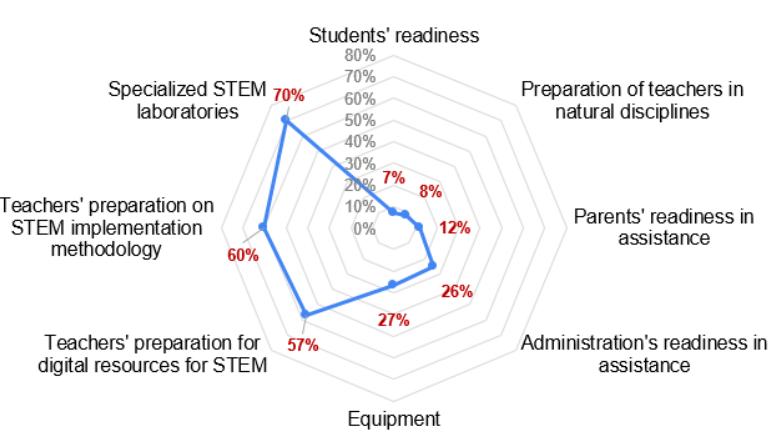
Figure 5: The result of the survey on the reasons that hinder the implementation of STEM education in